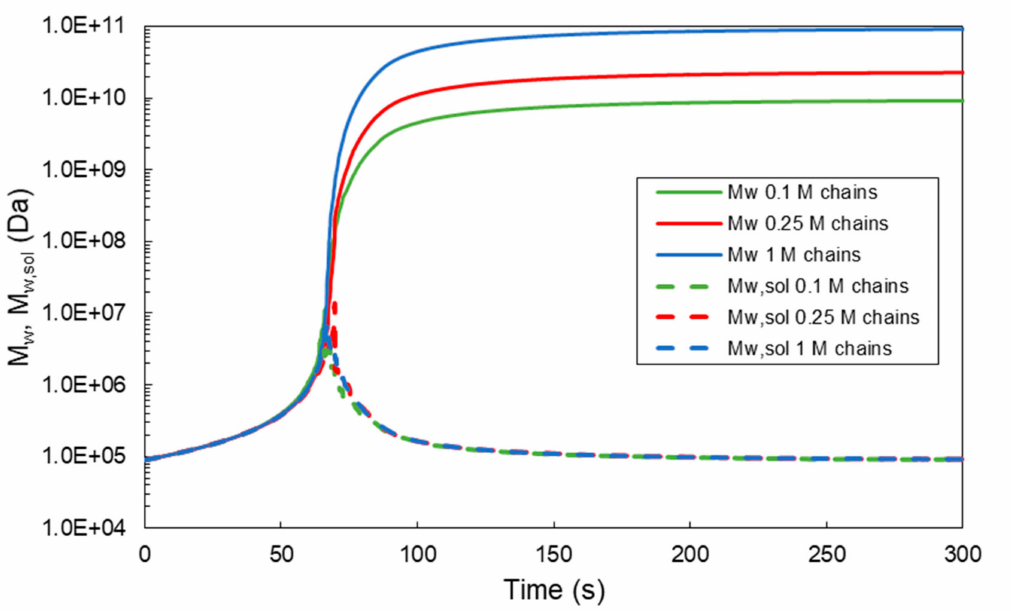
Figure 4. Effect of the initial number of polymer chains on the time evolution of the weight average molecular weight ( M w ) in the system and sol phase ( M w,sol ) for a HA-Tyr solution (i.e., 1.75% w/v , MW = 90 kDa, 0.124 units/mL HRP and 728- µ M H 2 O 2 )